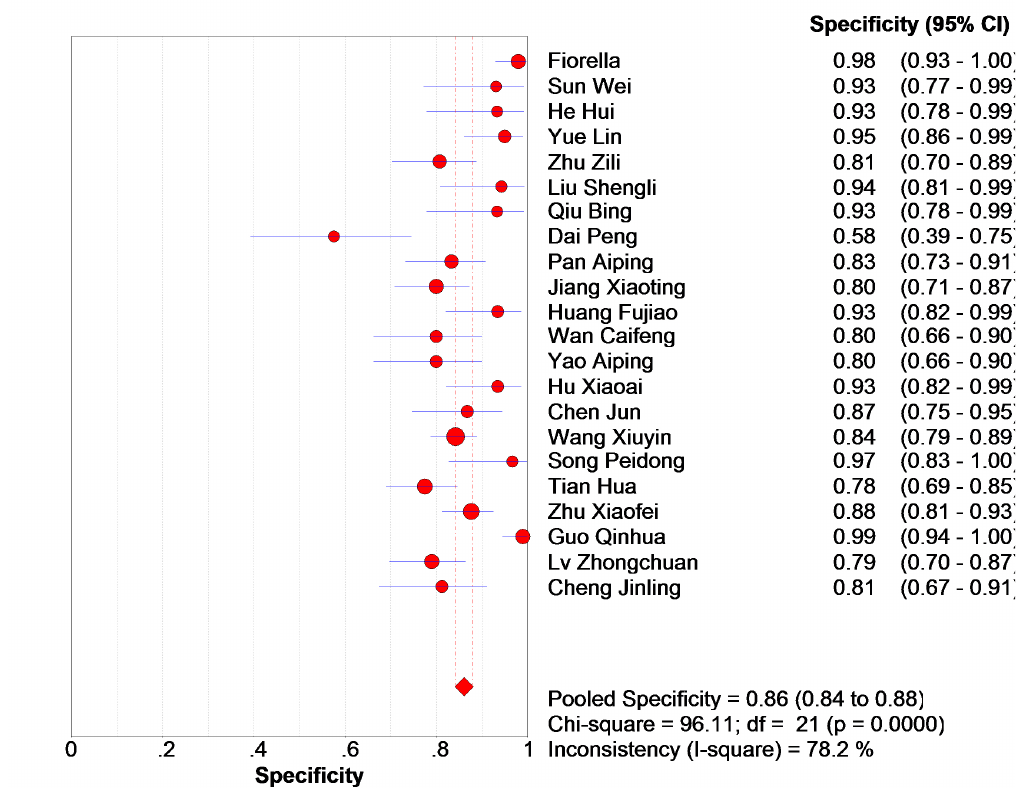
Figure 3: The diagnostic sensitivity of serum CA72-4 in the diagnosis of colorectal